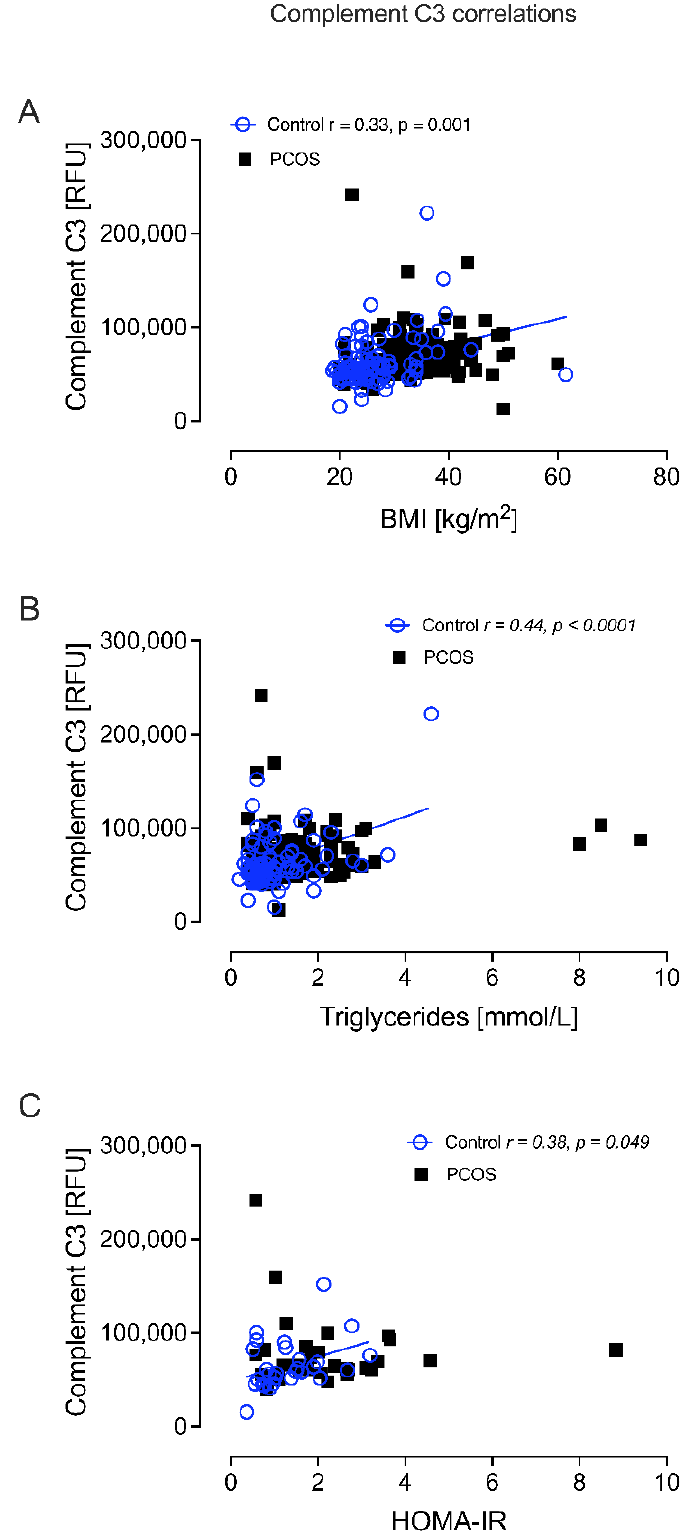
Figure 6. Complement C3 correlated significantly with BMI in controls ( A ), triglycerides in controls ( B ), and HOMA-IR in controls ( C ). HCFII correlated negatively with age in PCOS (r = −0 .21, p = 0.02); correlated posi- tively with BMI in controls (r = 0.30, p = 0.004); correlated positively with cholesterol in PCOS (r = 0.22, p = 0.01); correlated positively with TG in controls (r = 0.52, p < 0.0001) and PCOS (r = 0.36, p < 0.0001); correlated positively with CRP in controls (r = 0.31, p = 0.004) and PCOS (r = 0.29, p = 0.001) ; and correlated positively with HOMA-IR in controls (r = 0.40, p = 0.03) (Figure 7).